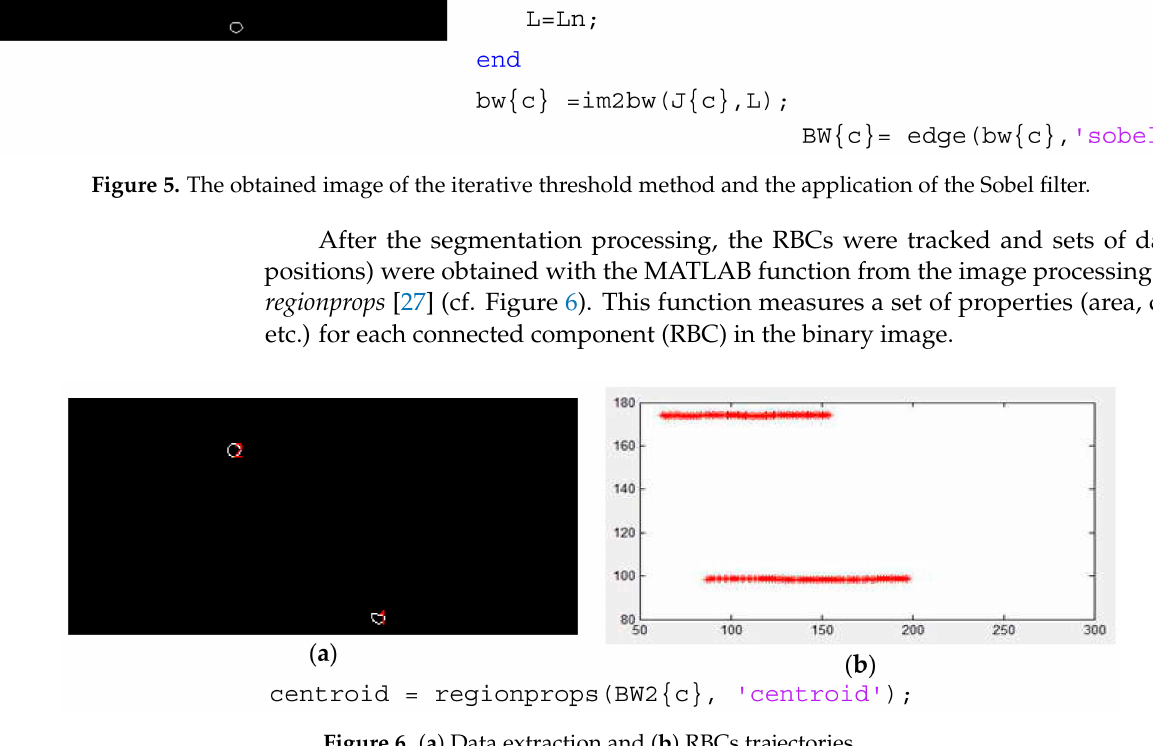
Figure 6. ( a ) Data extraction and ( b ) RBCs